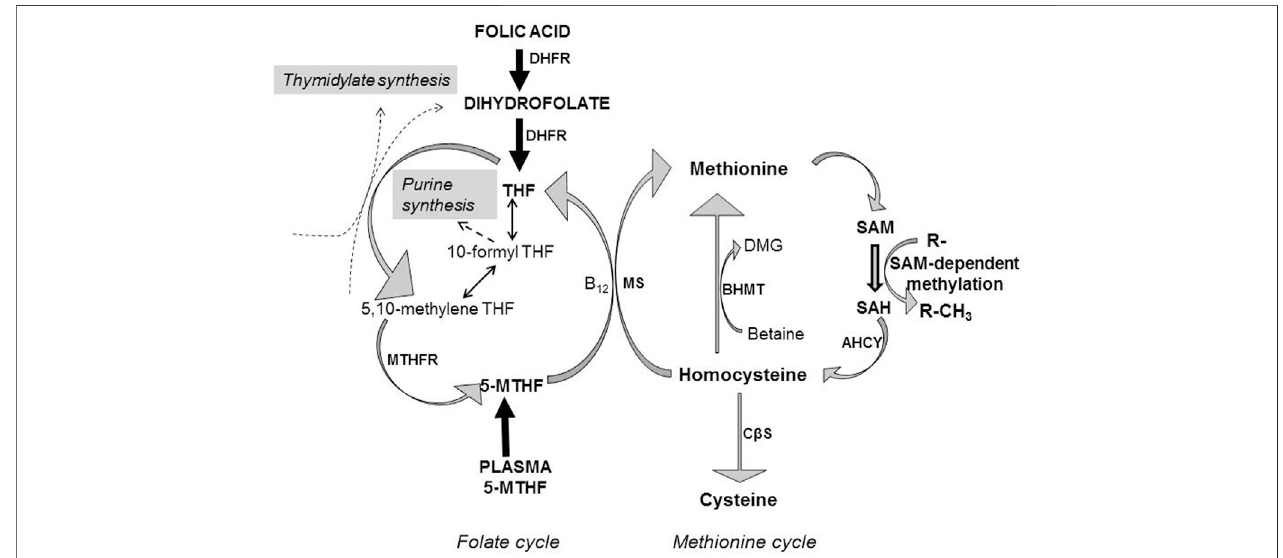
FIGURE 1 | Homocysteine metabolism is dependent on folate and methionine metabolism. Folic acid is reduced to dihydrofolate by the action of dihydrofolate reductase(DHFR),whichtogether withdietary dihydrofolateisreducedfurthertotetrahydrofolate (THF),whichentersthe folatemetabolic cycle.Alternatively,folatemay enterthefolatecycleas5-methyltetrahydrofolate(5-MTHF),withfolatecyclemetabolisminvolvedinthetransferofone-carbonunitstogeneratethymidylateandpurines for nucleotide biosynthesis. Methionine acts as the precursor for the ATP-dependent synthesis of the primary methyl donor S -adenosylmethionine (SAM) which through the action of methyltransferases transfer methyl groups to various acceptors (R-) resulting in the methylation of DNA, proteins and lipids, whilst generating S- adenosylhomocysteine (SAH). SAH is catabolized to homocysteine by S -adenosylhomocysteine hydrolase (AHCY). Homocysteine can be metabolised by three metabolic pathways. 1) Remethylation of homocysteine to methionine relies on 5-MTHF as methyl donor, catalysed by the vitamin B 12 -dependent action of methionine synthase (MS). THF is then re-cycled to form 5-MTHF, catalysed by methylenetetrahydrofolate reductase (MTHFR). 2) Betaine can be utilized as an alternative methyl donor to generate methionine and dimethylglycine (DMG), catalysed by betaine-homocysteine methyltransferase (BHMT). 3) Alternatively, homocysteine can enter the transsulphuration pathway being converted to cysteine through the action of cystathionine β -synthase (C β S).